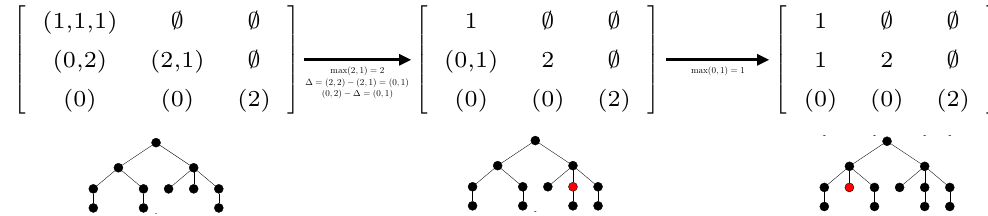
Figure 13. Progress of Algorithm 2 to compute the NEST of the left tree from its height profile. Only the second line must be edited to get the correct output. Editions of the height profile are associated with addition of vertices in red. The output tree is self-nested and has been constructed by adding a minimal number of nodes to the initial tree.